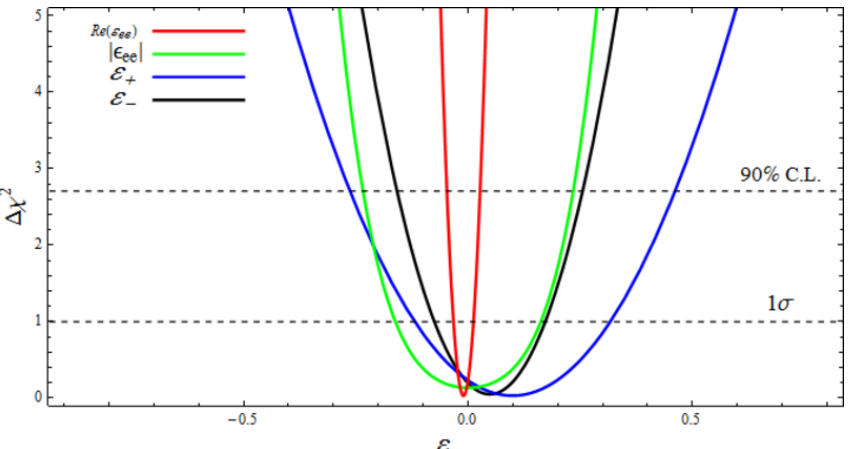
Figure 2 . Source NSI one parameter (cid:12)ts with the 1- (cid:27) or 68%C.L. and 90% C.L levels indicated by the horizontal dashed lines. The corresponding best-(cid:12)t values and 90% C.L. spread is shown in table 2. NSI Para.